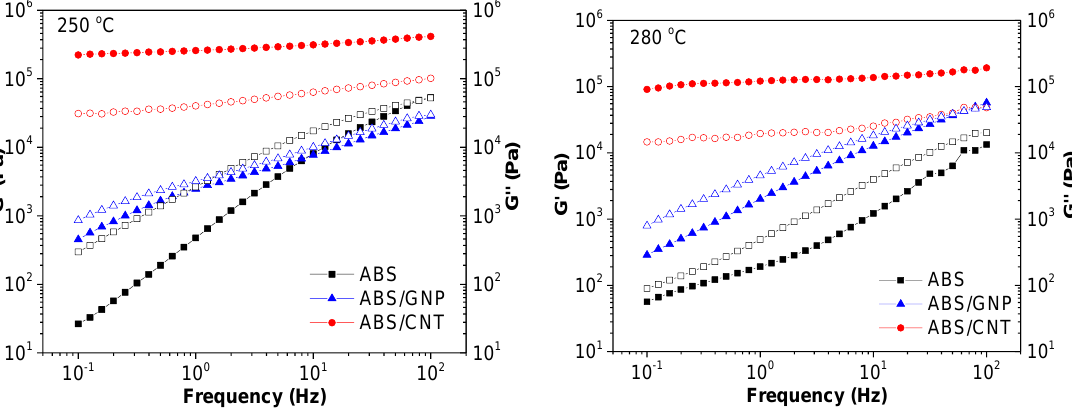
Figure 5. Storage modulus (full symbols) and loss modulus (open symbols) of ABS, ABS/GNP and ABS/CNT nanocomposites at 250 and 280 °C.